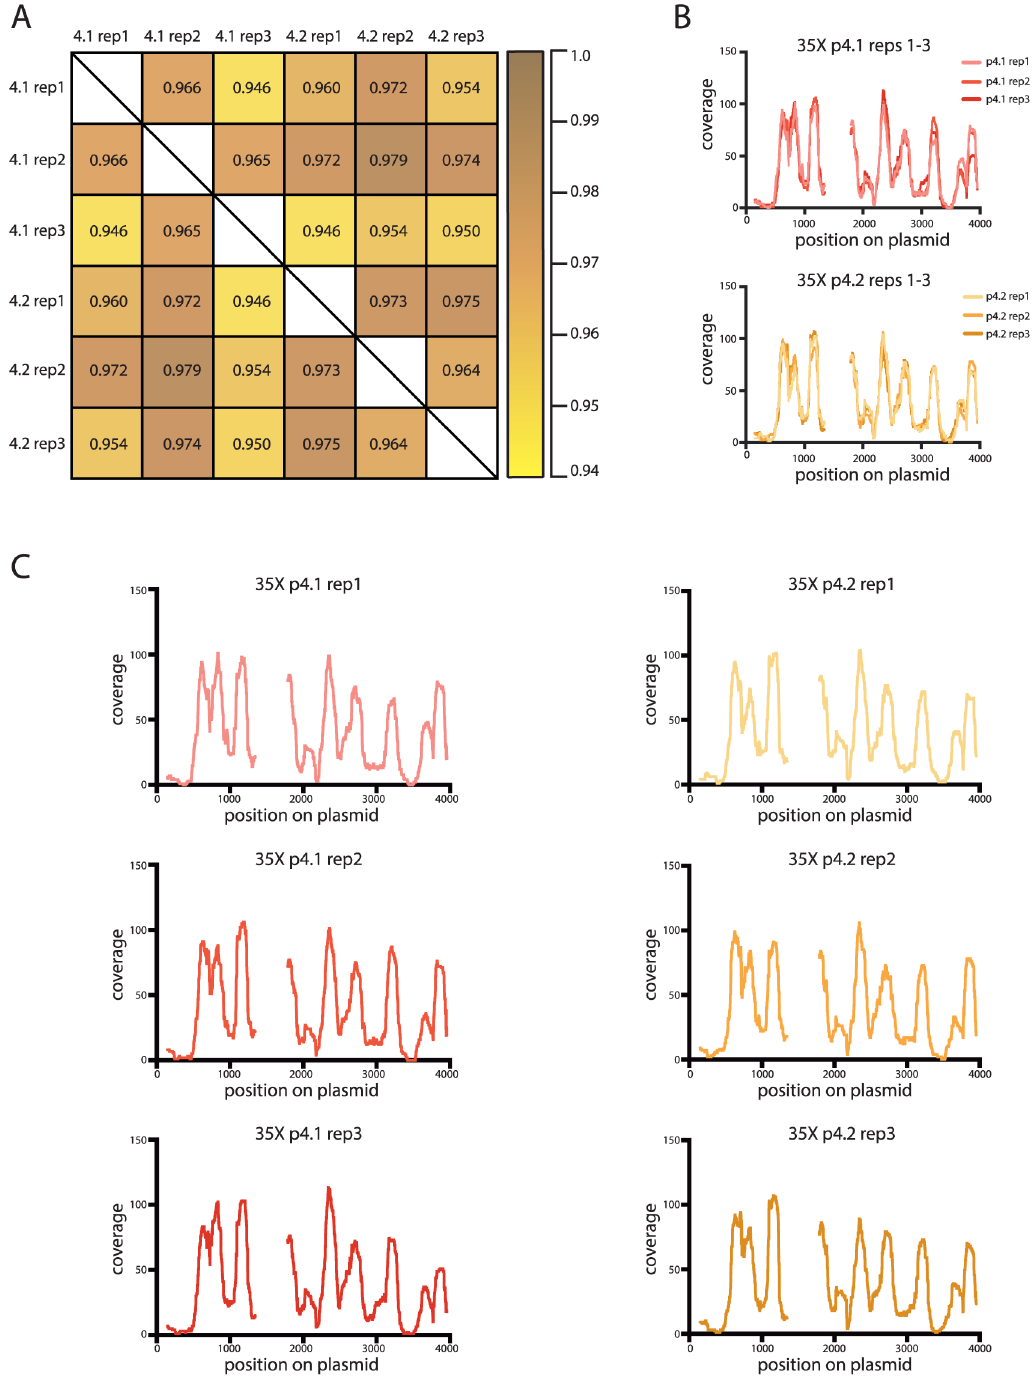
Figure 4. High correlations are maintained at experimentally relevant invitrosome coverage levels. 4A Pearson’s correlation matrix for the coverage plots generated from three replicates at 35X coverage of plasmids p4.1 and p4.2. 4B (top) Combined coverage plots for replicates 1-3 of plasmid p4.1 at 35X and (bottom) combined coverage plots for replicates 1-3 of plasmid p4.2 at 35X. 4C All six replicates of the 35X coverage plots. (Left) coverage plots of replicates 1-3 of plasmid p4.1 at 35X. (Right) coverage plots of replicates 1-3 of plasmid p4.2 at 35X.